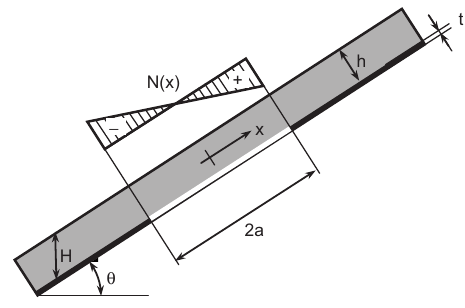
Figure 1 Geometry of the problem: snow slab of height h, weak layer of thickness t and super-weak zone of length 2a. H is the height of the fallen snow and N(x) the axial force in the debonded snow slab.